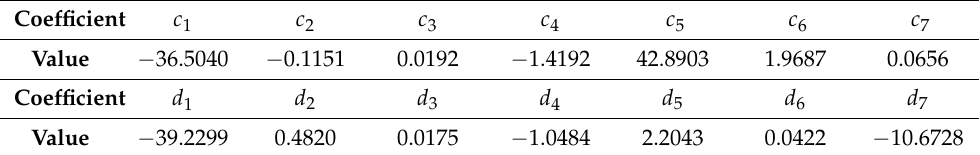
Table 10. The coefficients in Equation (18).